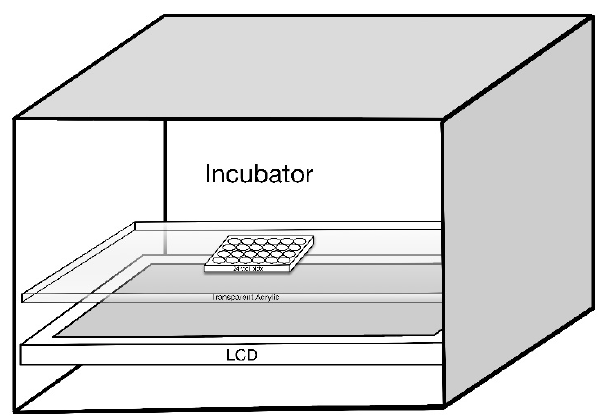
Figure 9. Schematic diagram of 661W cells seeded on a 24-well plate with the exposure of liquid crystal displays (LCD).